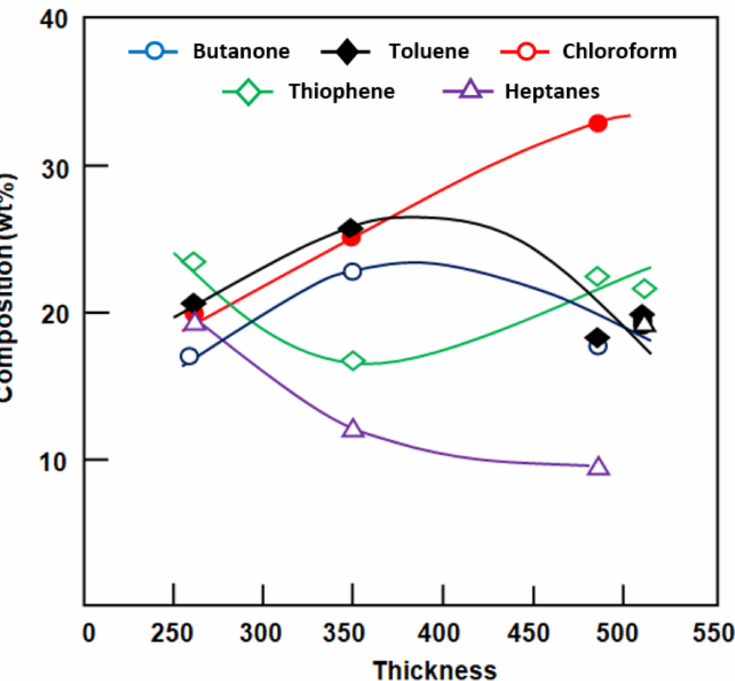
Figure 6. Variation of the concentration of various components in the organic mixture in the permeate as a function of the membrane thickness during the 1.5 h extraction